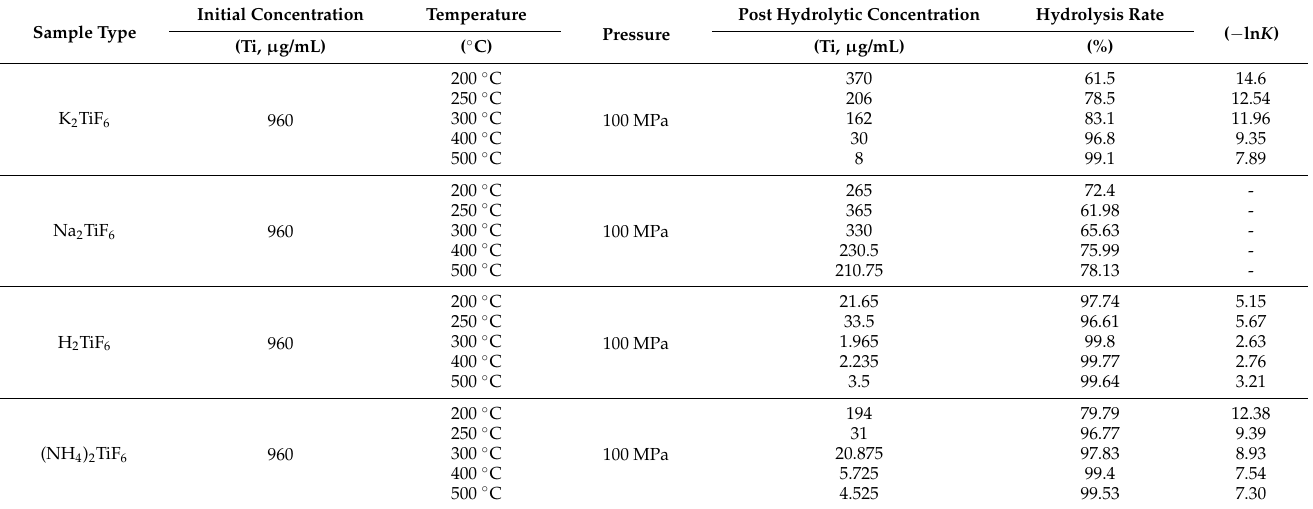
Table 1. Hydrolysis results of different F-Ti complexes for various temperatures at 100 MPa (>12